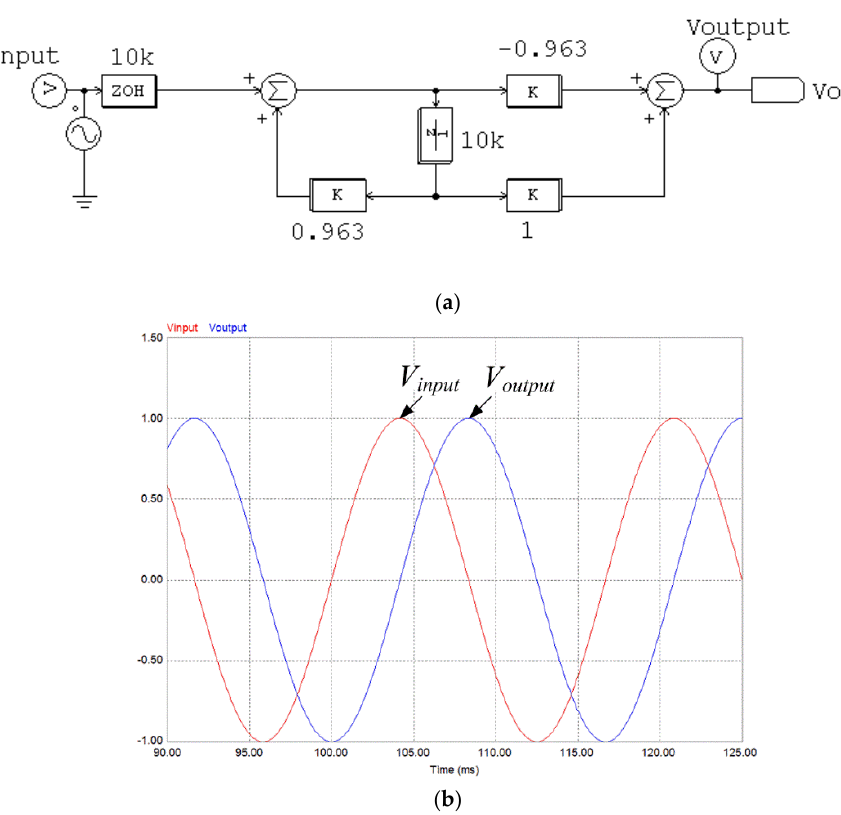
Figure 3. Digital all-pass filter simulation results for 90-degree out-of-phase lagging.